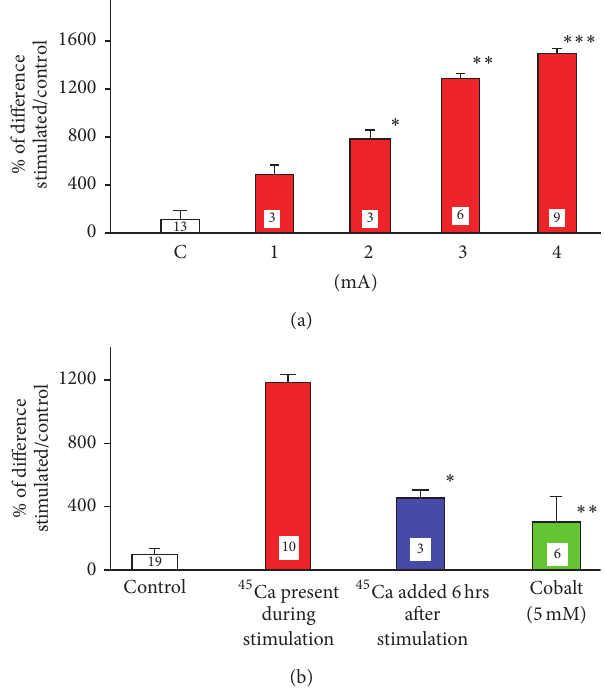
Figure 4: The influence of different experimental conditions on 45 Ca 2+ accumulation by synaptosomes. (a) Accumulation of 45 Ca 2+ by fractions of synaptosomes stimulated for 3 min by DC ranging from 1 to 4 mA. The results are presented as % of the differ- ence between stimulated and nonstimulated preparations. ANOVA followed by Holm-Sidak, 𝑝 < 0.001 ; ∗ 1 versus 2mA n.s.; ∗∗ 2 versus 3mA, 𝑝 < 0.001 ; ∗∗∗ 3 versus 4 mA, 𝑝 < 0.04 , 𝑡 -test. (b) The accumulation of by stimulated synaptosomal suspension while 45 Ca 2+ was either present in the tube during stimulation (red) or added to the tube 6 hrs after cessation of stimulation (blue); ∗ 𝑝 < 0.003 , 𝑡 -test, as compared to nonstimulated control. The accumulation of 45 Ca 2+ in the presence of 5mM cobalt (green); ∗∗ 𝑝 < 0.001 , 𝑡 -test, compared to synaptosomes stimulated in the presence of 45 Ca 2+